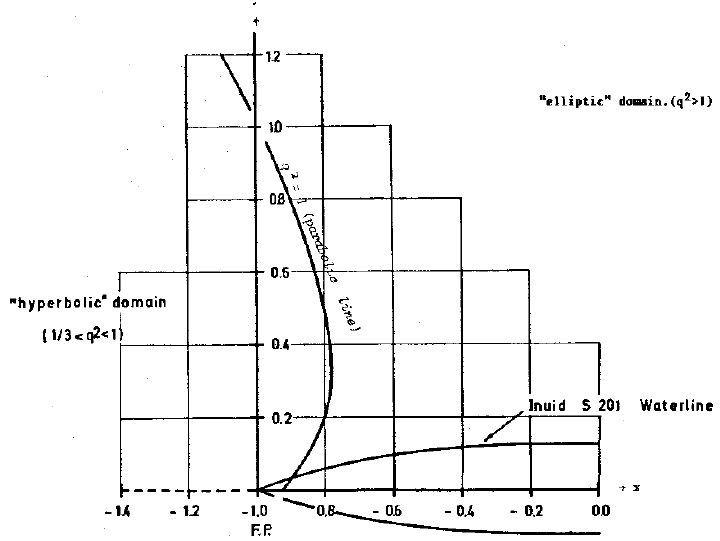
Figure 17. “Hyperbolic” and “elliptic” domains in the flow around the moving ship [30].